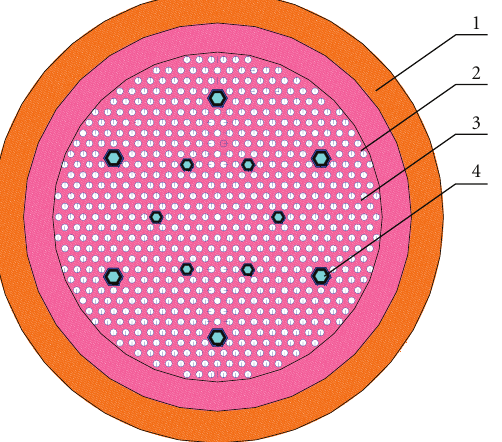
Figure 1: Core design with hard spectrum fuel assemblies sur- rounded by fuel assemblies with thermal spectrum. 1: graphite reflector, 2: heavy water moderator and reflector, 3: fuel assemblies with thermal spectrum, 4: fuel assemblies with hard spectrum.